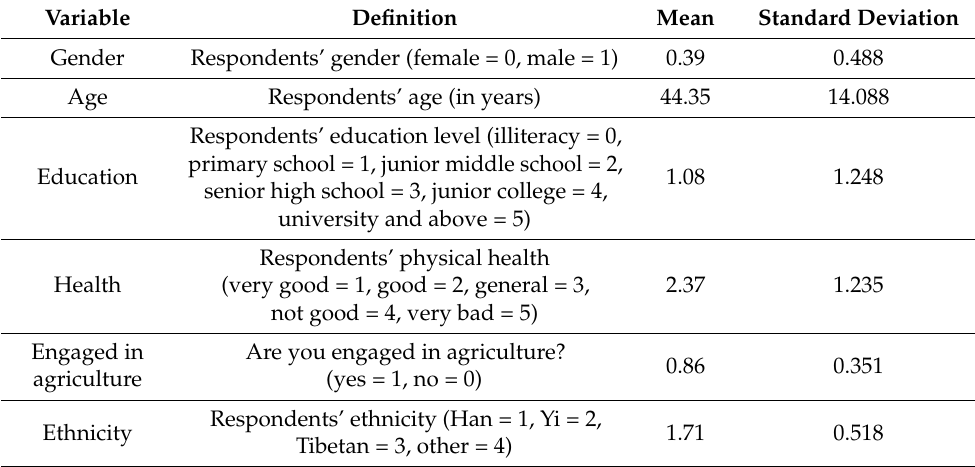
Table 2. Descriptive statistics of the